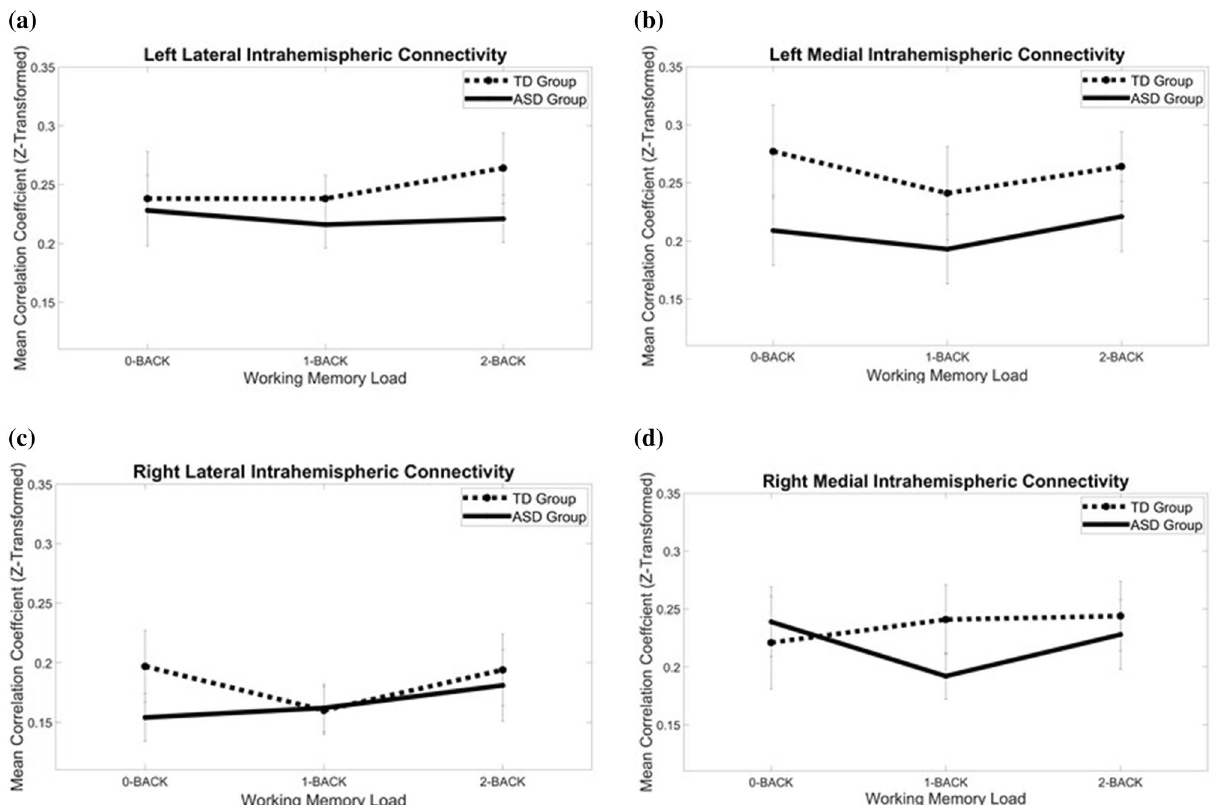
Figure 4. The effect of n-back task load on the ( a ) left lateral, ( b ) left medial, ( c ) right lateral and d) right medial intrahemispheric functional connectivity changes in the prefrontal cortex in TD and